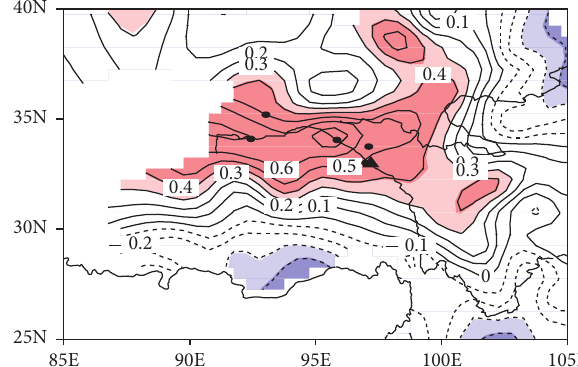
Figure 4: The lag correlation between rainfall and runoff at the Zhimenda station with rainfall leading runoff by 15 days. The dark (light) shading indicates the correlation coefficients significant at the 99% (95%) confidence level. The black circular points represent five meteorological stations that were selected in Section 5. The black triangle represents the Zhimenda station.